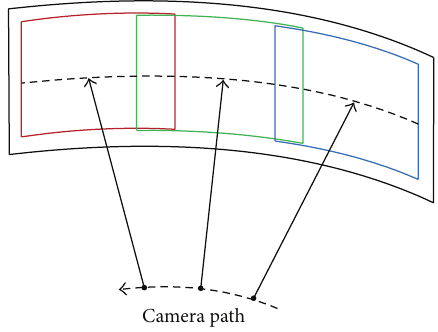
Figure 1: The camera path and its motion mode.